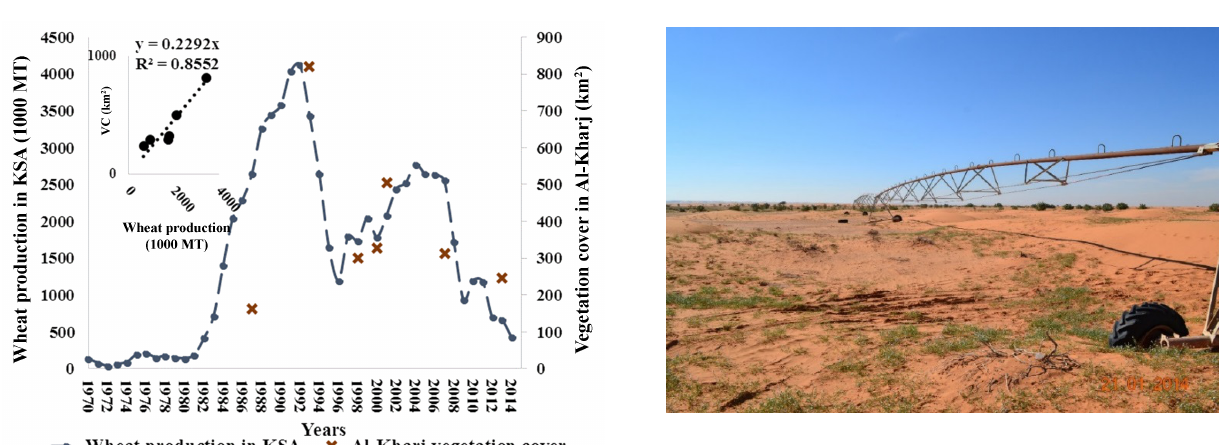
Figure 8. Sand dune encroachment in eastern part of the Al-Kharj